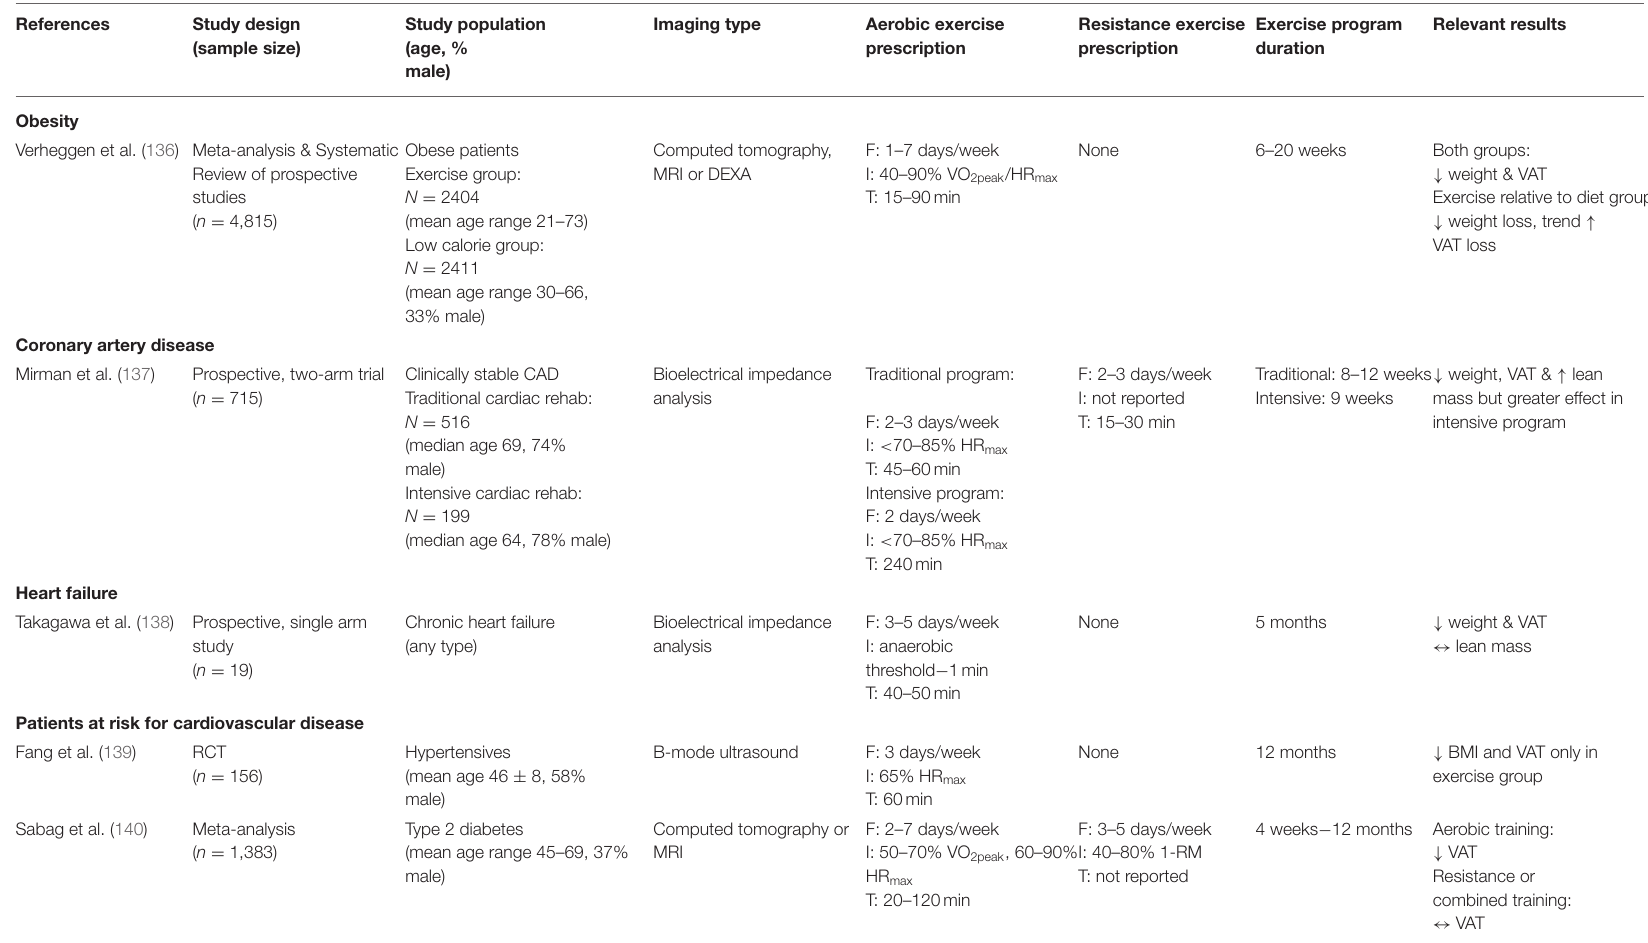
TABLE 3 | Characteristics of the studies reporting on the extra-cardiac effects of exercise